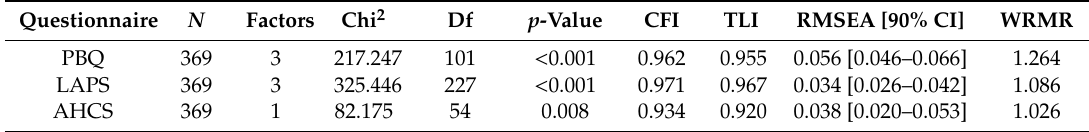
Table 1. Fit indices of the Confirmatory Factor Analysis for each